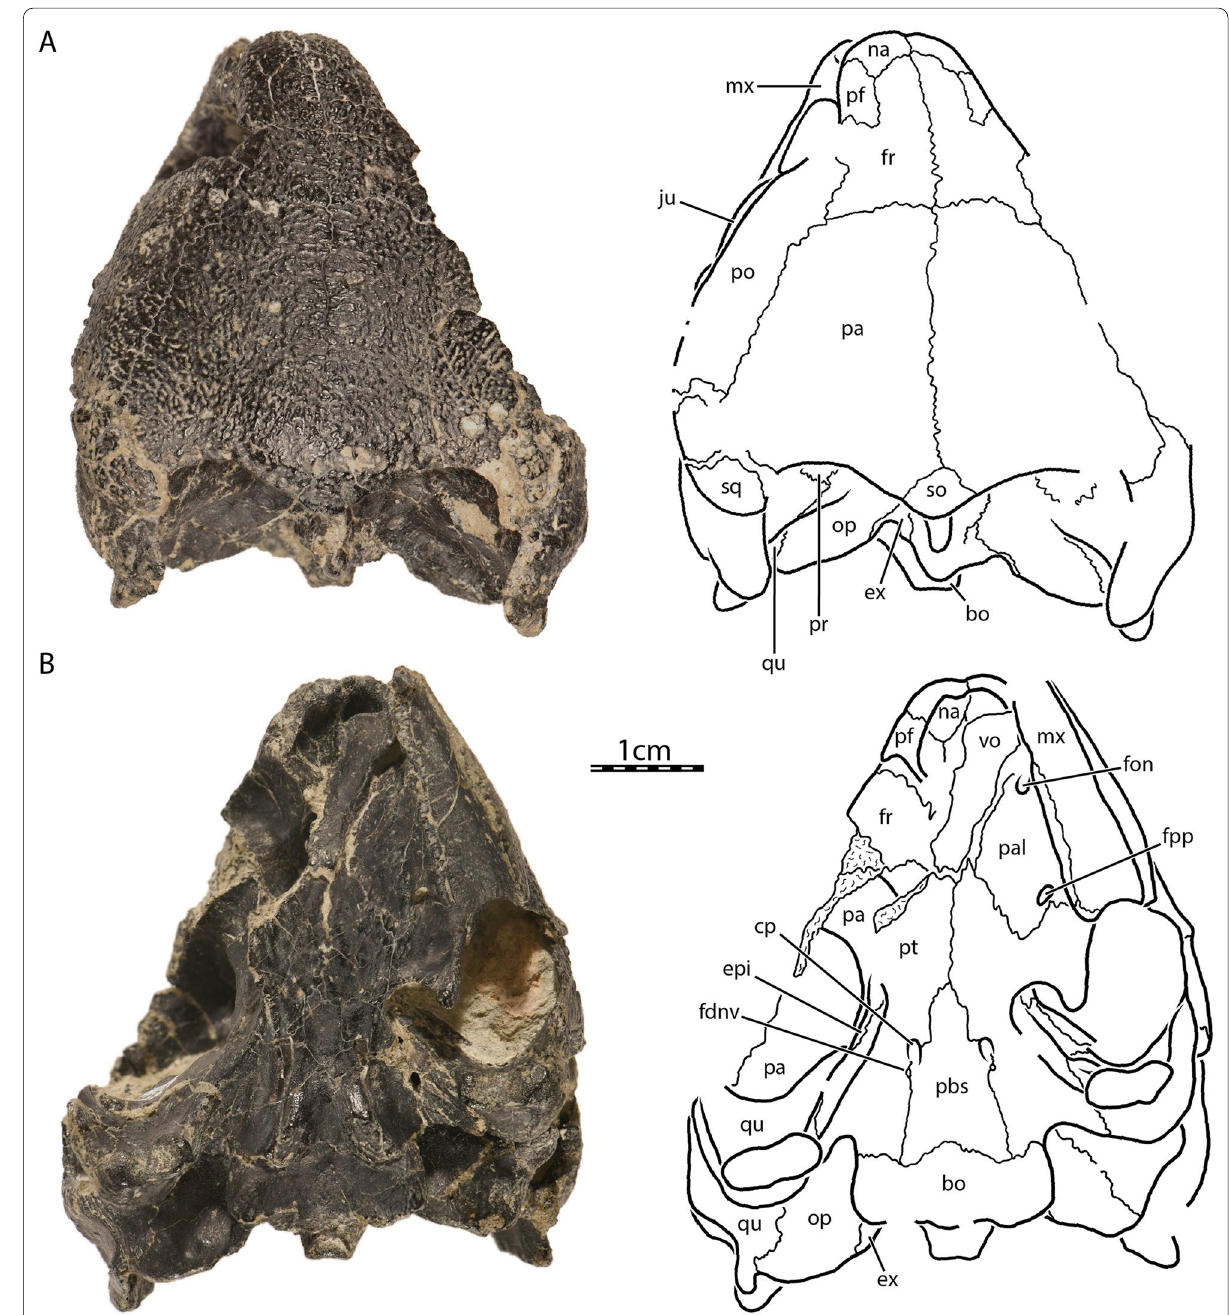
Fig. 1 Uluops uluops , UCM 53971, Late Jurassic (Tithonian) of Wyoming, U.S.A. Photographs and illustrations of skull in A dorsal, and B ventral views. bo basioccipital, cp carotid pit, ex exoccipital, fdnv foramen distalis nervi vidiani, fon foramen orbito-nasale, fpp foramen palatinum posterius, fr frontal, ju jugal, mx maxilla, na nasal, op opisthotic, pa parietal, pal palatine, pbs parabasisphenoid, pf prefrontal, po postorbital, pt pterygoid, qu quadrate, so supraoccipital, sq squamosal, vo